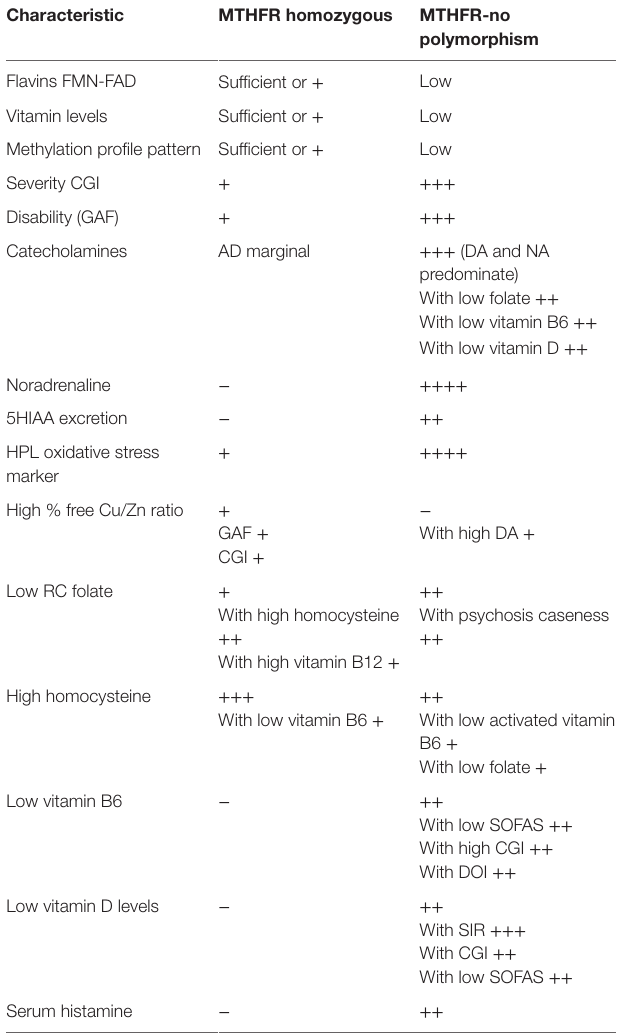
TaBle 9 | summary comparison of two main MThFr variant – biochemical types, based upon combined findings from correlation, seM, and significance indices [sis] for caseness (Tables 7 and 8; Figures 3 and 4).